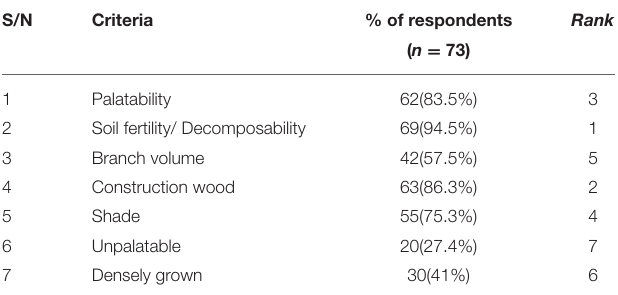
TABLE 4 | Farmers strategies to characterise trees and shrubs in their